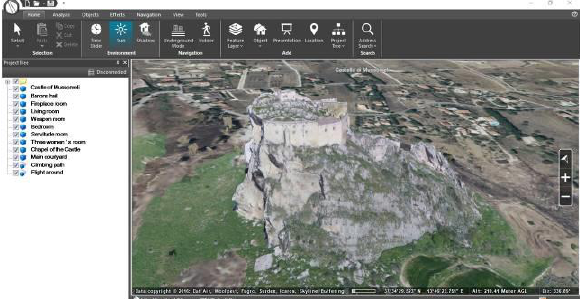
Figure 13. The virtual navigation in the model generated with the commercial proprietary solution